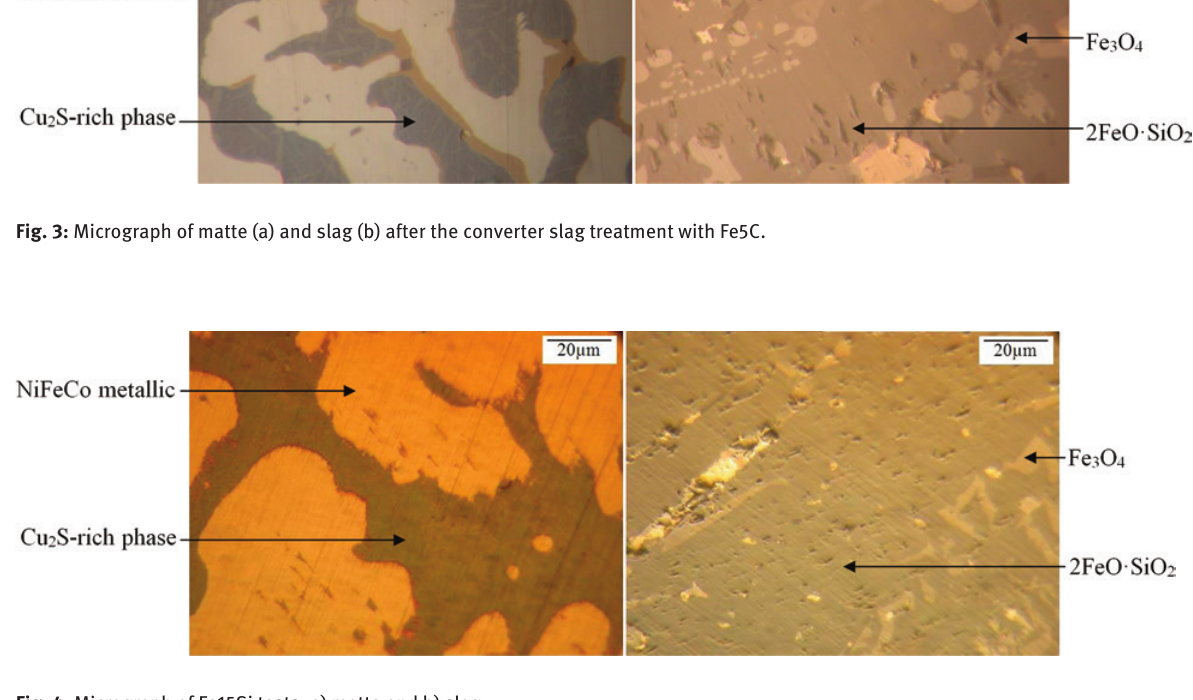
Fig. 4: Micrograph of Fe15Si tests. a) matte and b)